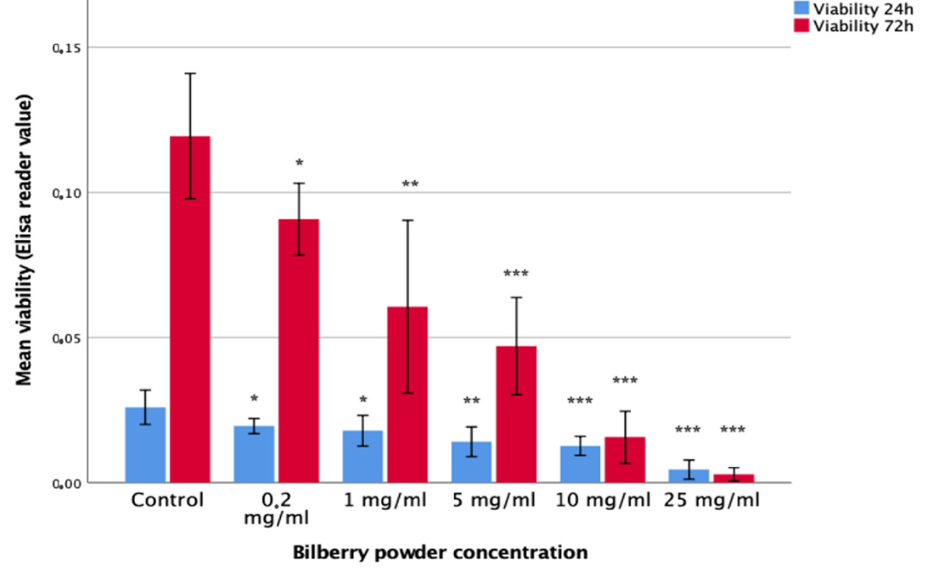
Figure 1. Viability of HSC-3 cells after 24- and 72-h bilberry powder incubations. Statistical test between control and different bilberry powder concentrations: * p < 0.05; ** p < 0.01; *** p < 0.001; 95%CI error bars.